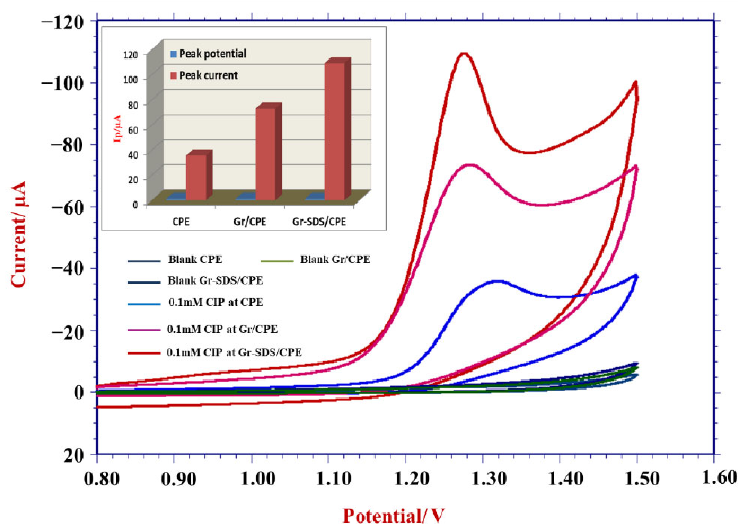
Figure 2. Electrochemical nature of CIP (0.1 mM) at different electrodes at pH 4.2 of phosphate buffer solution (PBS) at a scan rate of 0.05 Vs − 1 .